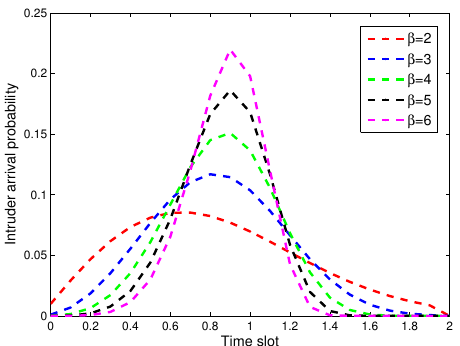
Figure 4. The probability between two arrival times for the